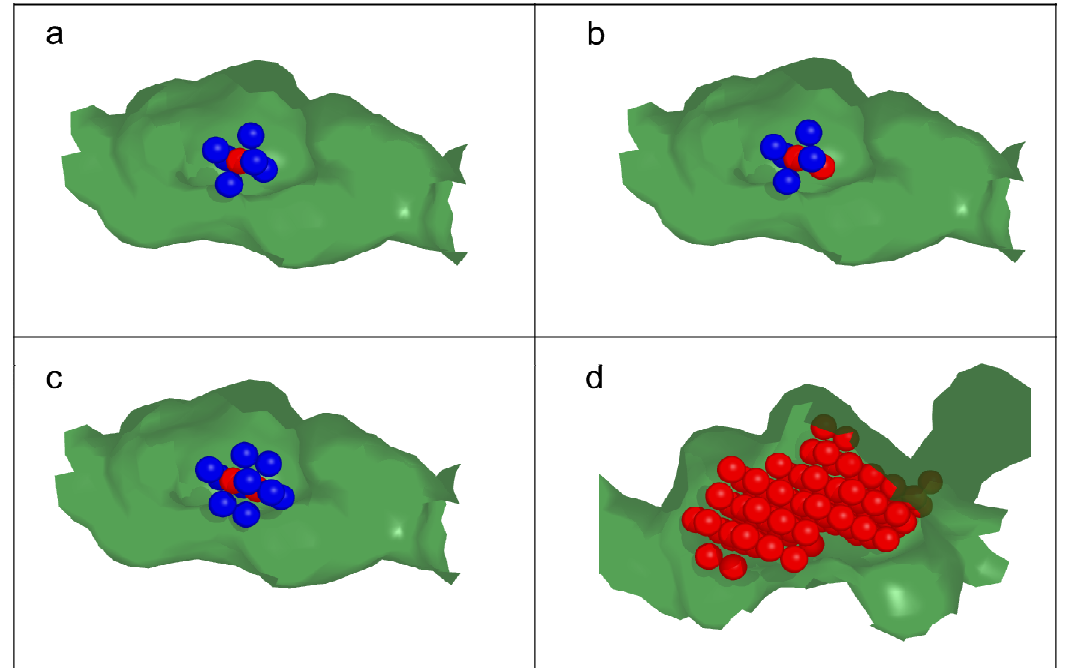
Figure 2. Active Site Pressurisation methodology. ( a ) The first particle in the cast is centred in a binding site and activated (red). The surrounding latent particles (blue) are arranged on a cubic grid and are held in fixed space; ( b ) A simulation of normal protein movement is performed over a short time period. The forces acting on latent particles adjacent to the activated central grid particle are accumulated. The latent particle experiencing the lowest force is activated and becomes part of the cast; ( c ) The simulation is restarted and the process is repeated; ( d ) Over a number of iterations the grid particles in the catalytic site expand in a direction that exploits the greatest flexibility in the protein structure and creates an optimal